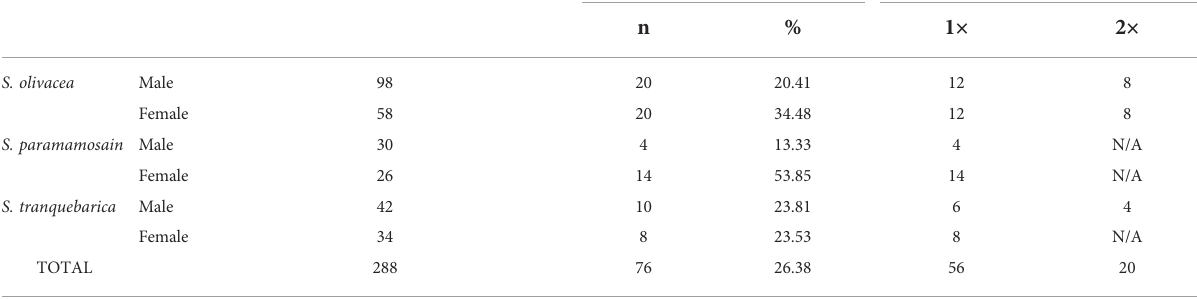
TABLE 1 Percentage of crab captured and tagged crabs